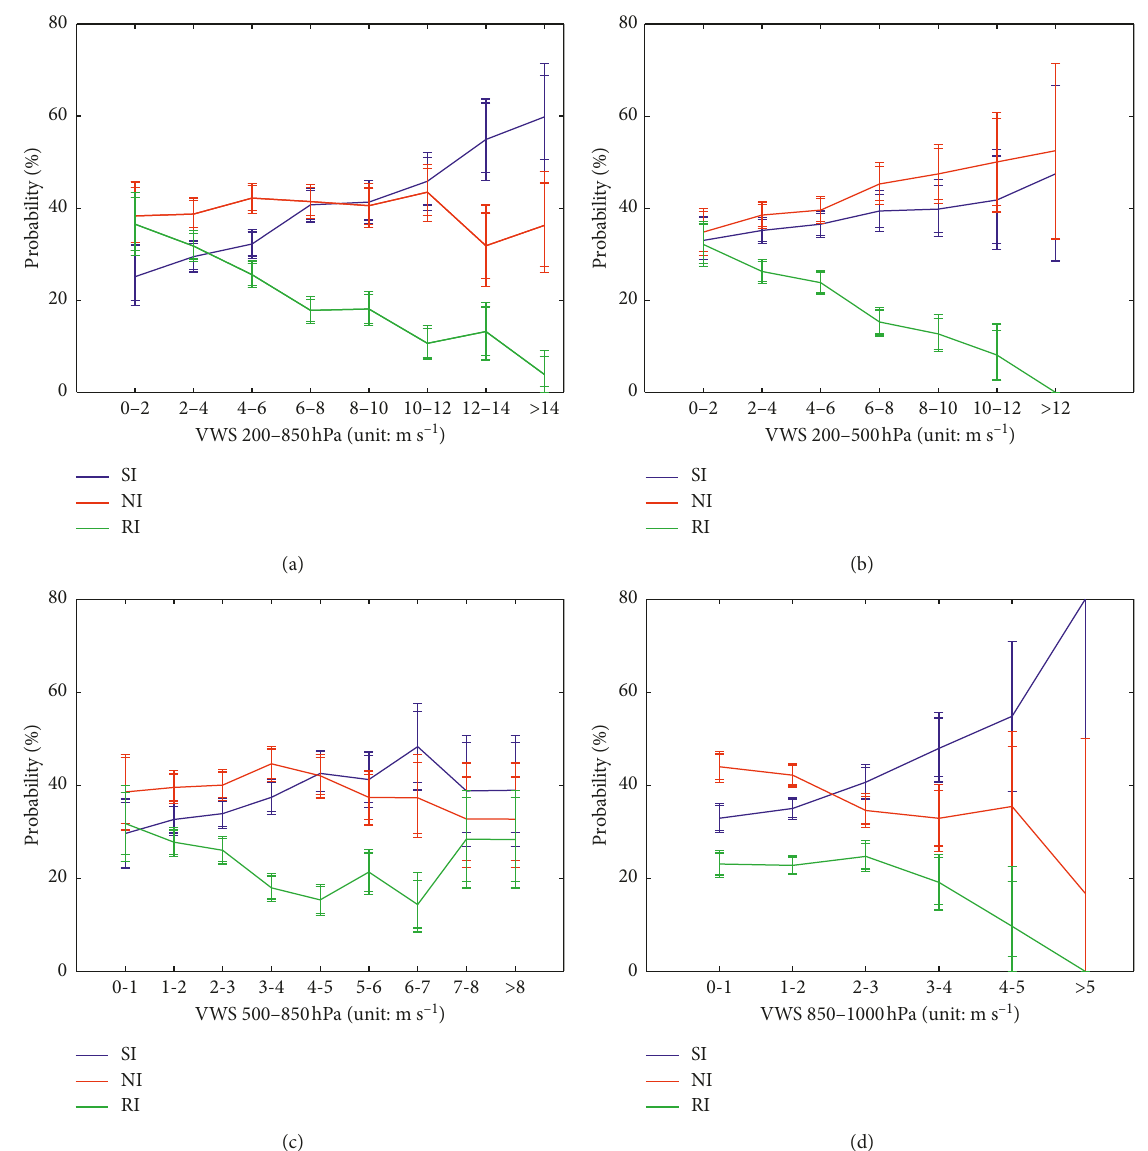
Figure 9: The probability distribution of the three intensity change categories (SI, blue; NI, red; and RI, green), in each VWS bin (m s − 1 ): (a) deep-layer shear VWS ; (b) upper-mid shear VWS ; (c) mid-low shear VWS ; (d) low-level shear VWS . The thick 200 − 850 200 − 500 500 − 850 850 − 1000 and thin error bars are the 95% and 90% confidence intervals,